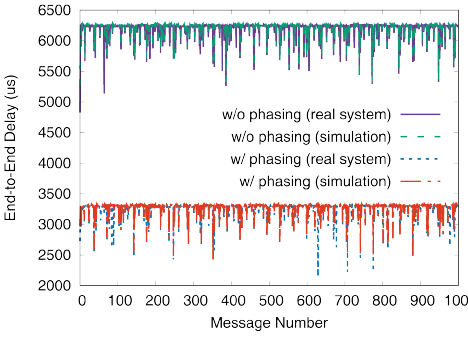
Figure 14. D e 2 e distribution of VC 1 in test set